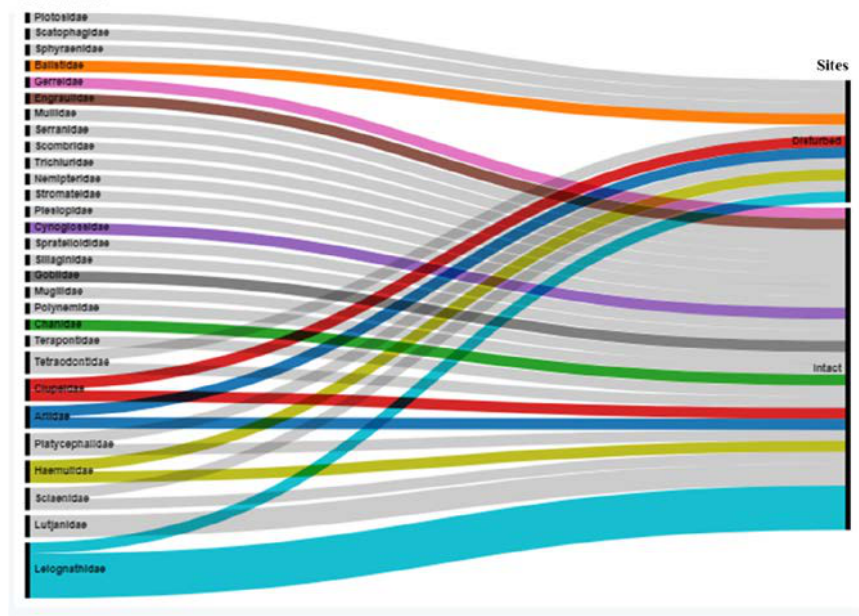
Fig. 7: Fish family compositions at disturbed (a) and intact (b) sites on West Java coast